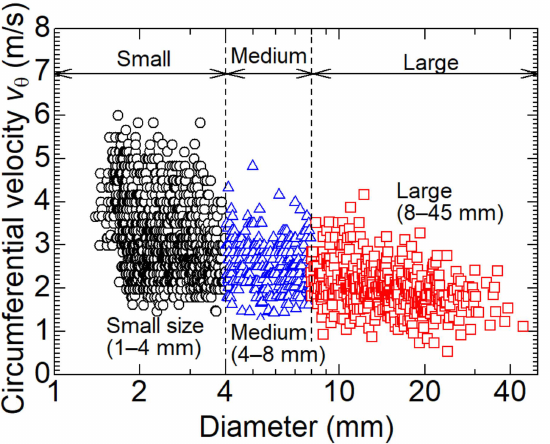
Figure 10. Relationship between the particle diameter and the circumferential velocity v θ